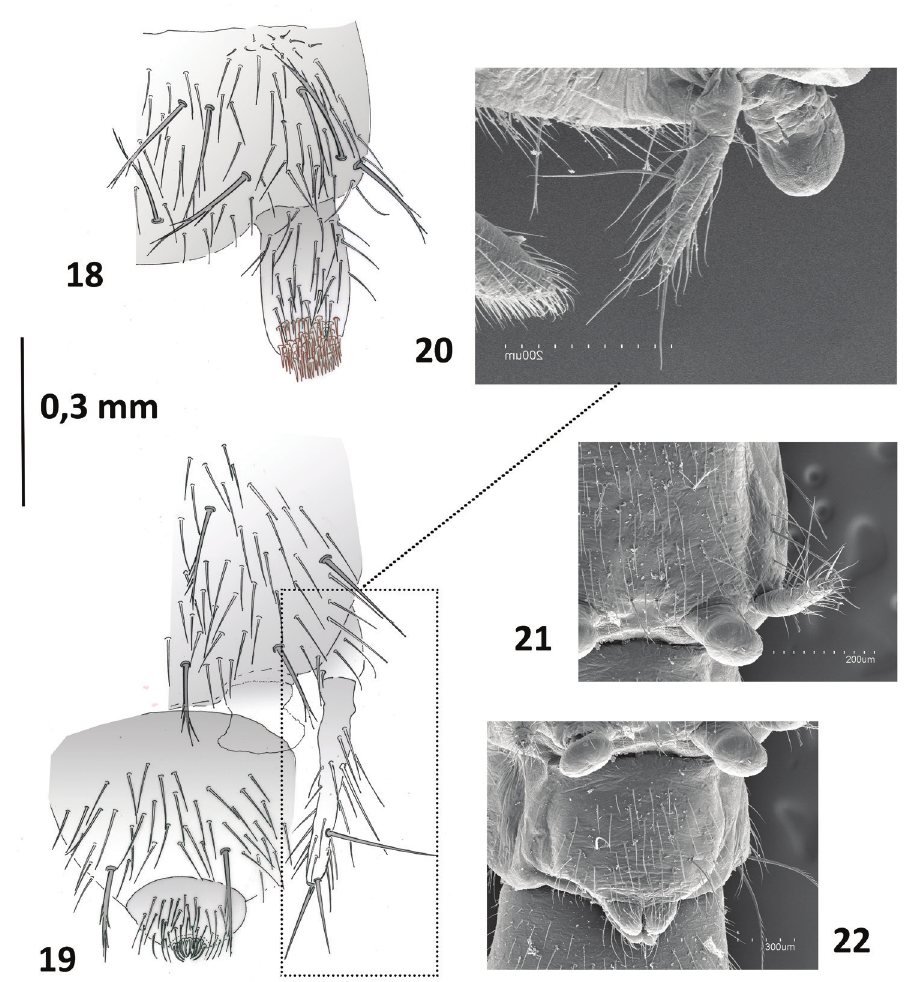
ternite VII (left side) plus urosternite VIII, ♂ paratype 20 Stylus urosternite II, paratype 21 Urosternite VI, left side, ♀ paratype 22 Urosternite VIII, ♀